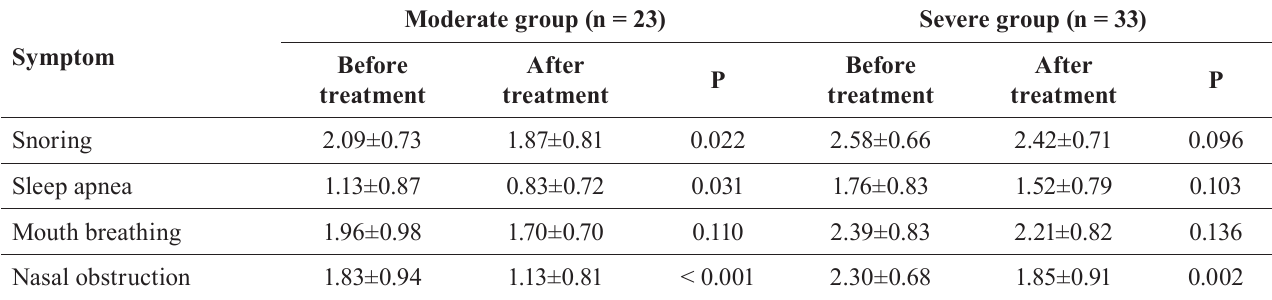
TABLE II - Symptom scores before and after treatment in two groups (points)